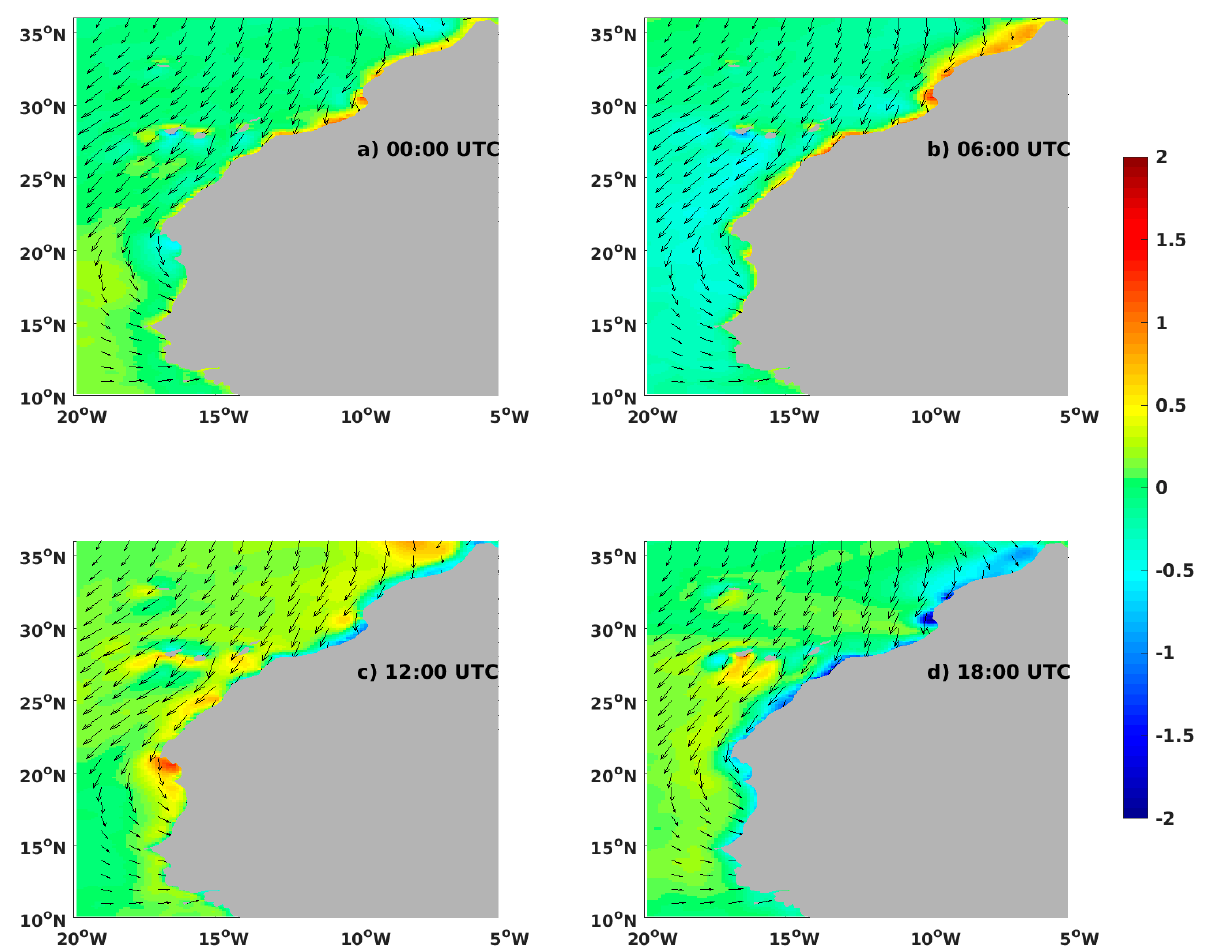
Figure 10. Diurnal 10 m wind speed anomaly (shaded, m s − 1 ) estimated as the difference between the seasonal mean for a given synoptic time and the seasonal mean for all synoptic times for January, and the seasonal mean wind velocity for each synoptic time. Results are based on the IFREMER wind analysis, seasonal means are computed over 2000–2018.